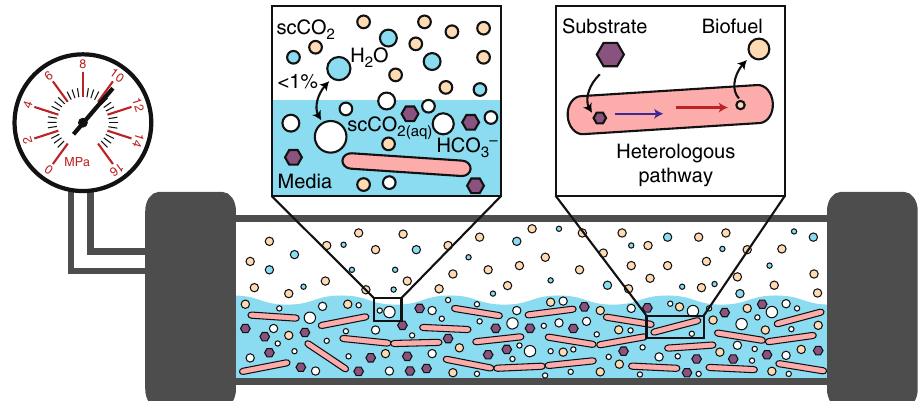
Fig. 1 Schematic of integrated fermentation and extraction under supercritical CO 2 . A scCO 2 -tolerant microbe can be engineered to produce compounds, such as medium-chain alcohols (C4-C5), that may serve as biofuels and may be preferentially extracted from aqueous media into the scCO 2 phase. Collection of scCO 2 followed by partial de-pressurization will facilitate high-purity biofuel extraction. The presented biphasic scCO 2 separation strategy is expected to simultaneously provide a contaminant-free environment for the engineered organism due to the broad microbial lethality of scCO 2 , and continuously strip microbially produced biofuels to eliminate end-product toxicity. scCO 2 is only weakly soluble in the aqueous media phase ( < 1%) and vice versa, resulting in a